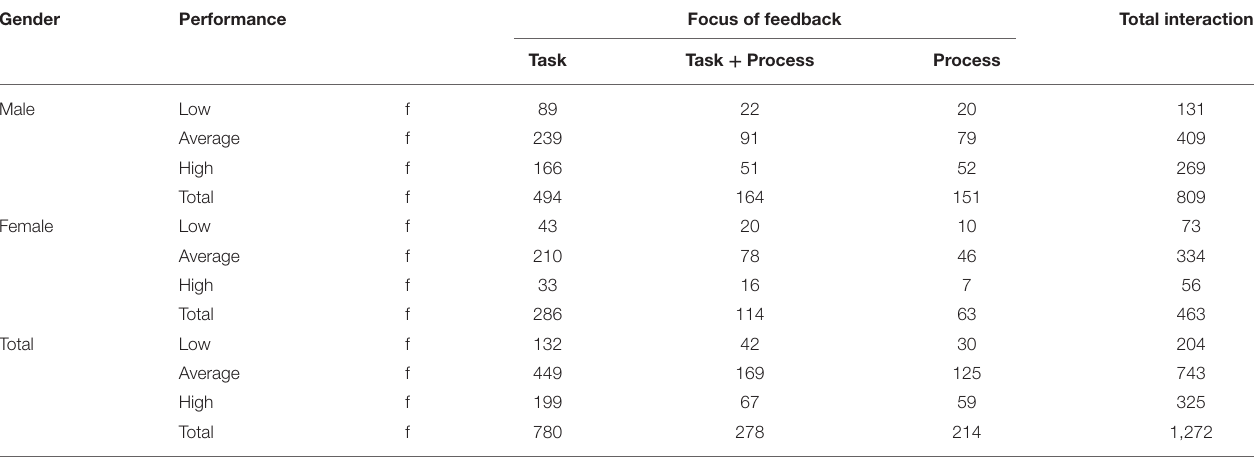
TABLE 10 | Frequency of the focus of feedback according to students’ gender and prior achievement. Gender